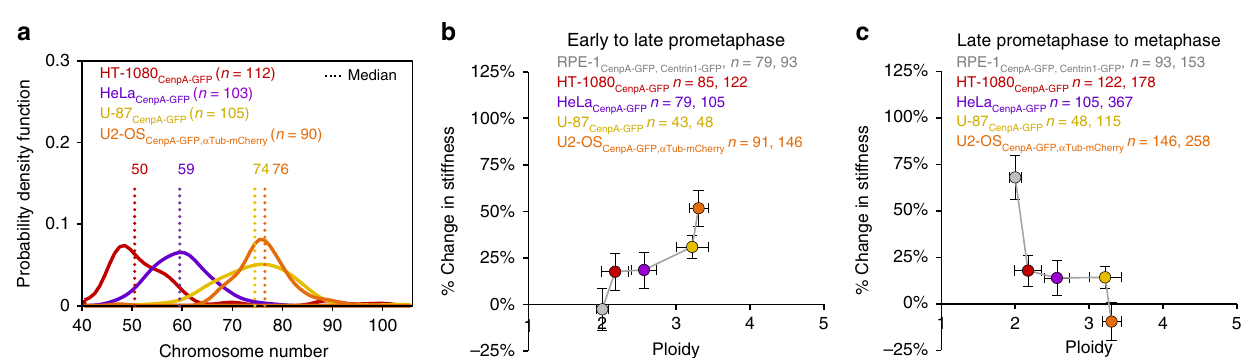
Fig. 7 Mechanical maturation of the centromere correlates with ploidy in cancer cells. a Probability density functions for individual observations of total chromosome number in HT-1080, HeLa, U-87, and U2OS cells. Sample sizes ( n ) re fl ect the number of cells per sample. Dotted lines and data labels indicate the median chromosome number in each cell line. b , c Relationship between percent change in mean centromere stiffness and ploidy for early- to late-prometaphase (L) and late-prometaphase to metaphase (M) across the four cancer cell lines, with data from non-cancerous RPE-1 cells shown for comparison. X -axis error bars represent IQR; Y -axis error bars represent standard error. All n-values listed are chromosome numbers. See also